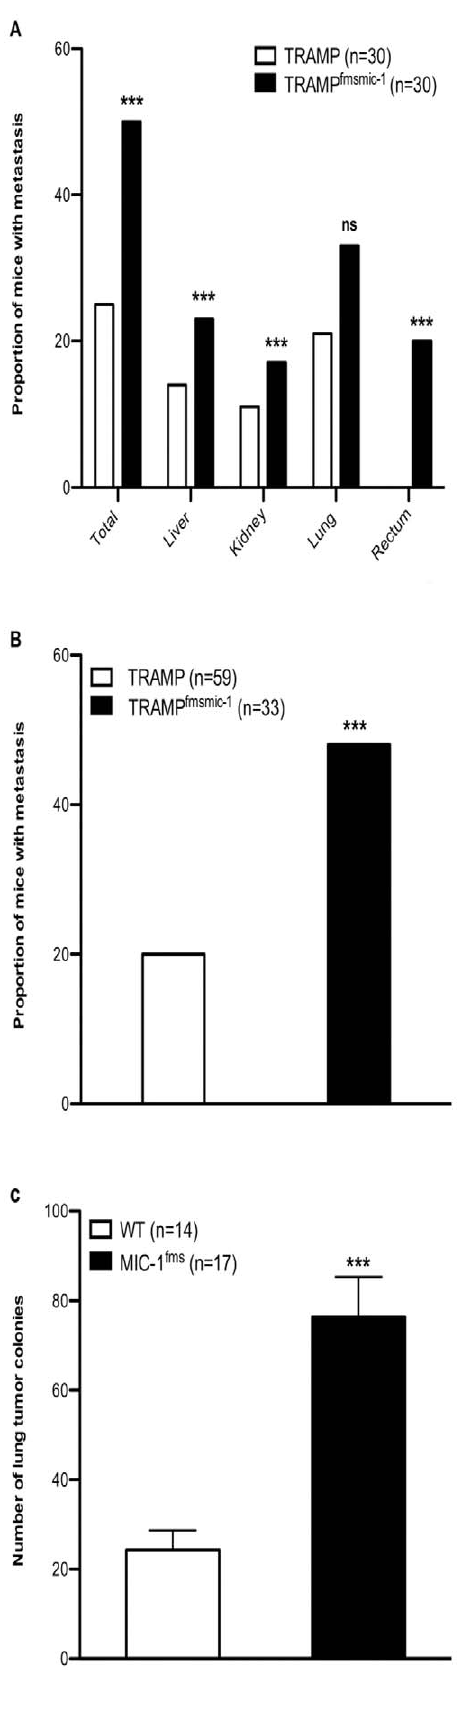
Figure 4. MIC-1/GDF15 increases metastasis. (A) Comparison between proportion of TRAMP (n=30) and TRAMP fmsmic-1 (n=30) mice having distant organ metastasis. The data is analyzed by Chi-square test. (B) Comparison between proportion of TRAMP (n=59) and TRAMP fmsmic-1 (n=33) mice with metastasis at 18–40 weeks, a period where TRAMP and TRAMP fmsmic-1 mice reach ethical end points at the same rate. The data is analyzed by Chi-square test. (C) Comparison between number of lung tumor colonies in MIC-1 fms mice and control C57BL/6 mice injected intravenously with TC1-T5 cells. The data is analyzed by Unpaired t test. The p values for Chi-square test and Unpaired t test are shown as ***p ,